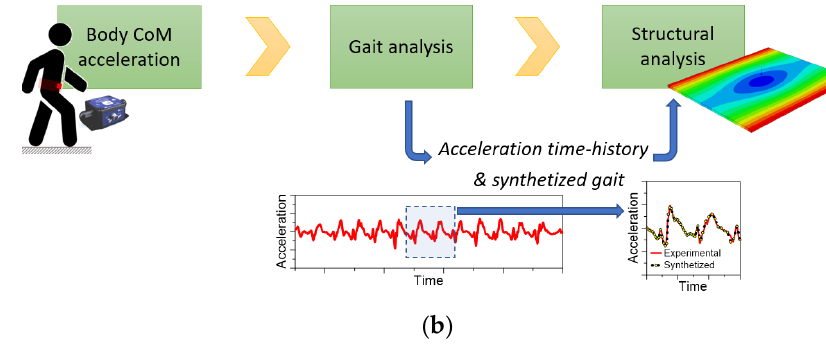
Figure 2. Gait variability and walk-induced effects on structures based on ( a ) deterministic loads (examples of gait-induced loads for different walking frequencies f s ) or ( b ) present procedure.